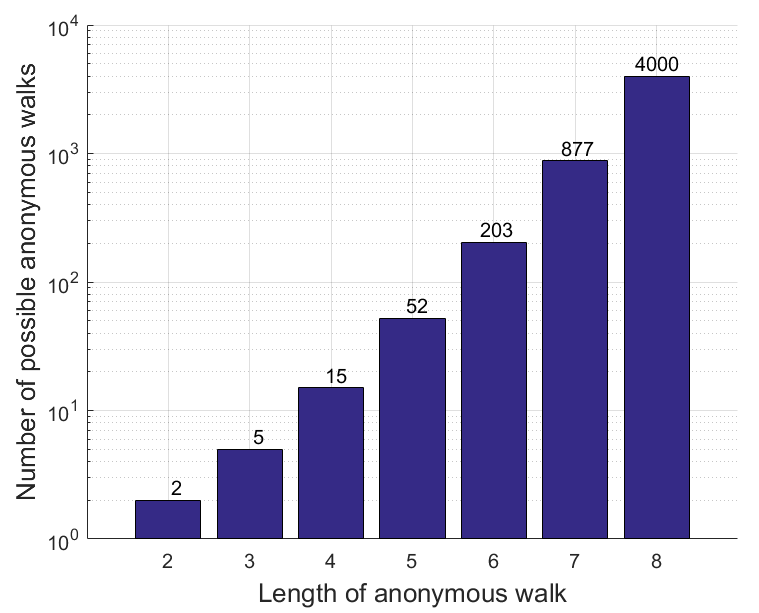
Figure 4. Number of possible anonymous walks in relation to walk length.